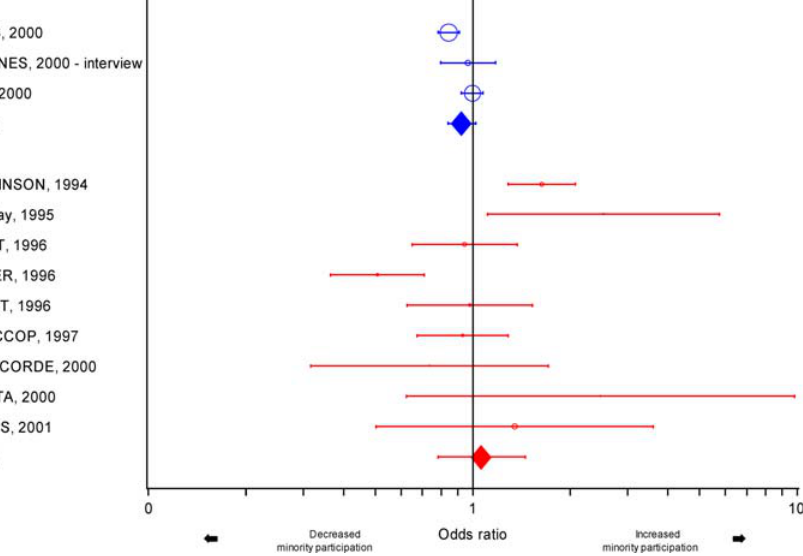
Figure 2. Comparison of African-American versus non-Hispanic White Consent Rates Circle diameter is proportional to the sample size of the individual studies. The diamond represents the overall OR. The vertical line indicates the 95% confidence interval on the OR. Blue indicates interview and non-intervention studies; red indicates clinical intervention studies. DOI: 10.1371/journal.pmed.0030019.g002